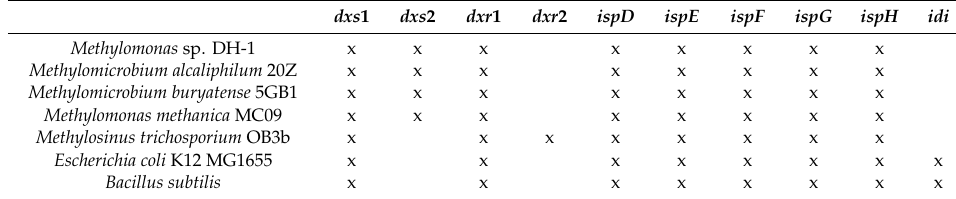
Table 1. The existence of genes encoding the methylerythritol 4-phosphate (MEP) pathway in methanotrophs and other microbes.